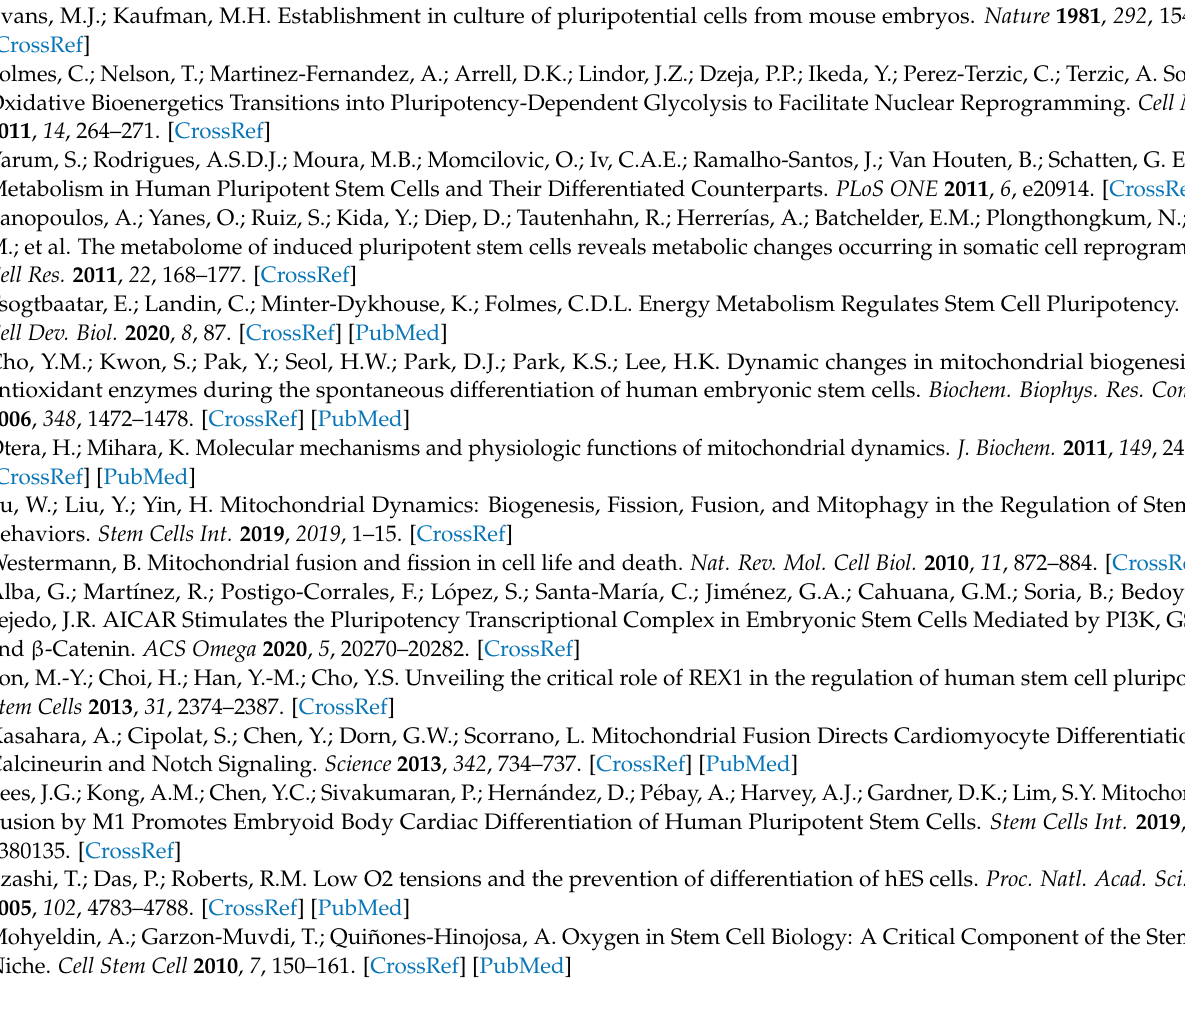
ESCs. Figure S4: 2 µ M DETA-NO reduces red-JC-1 aggregation in human iPSCs. Table S1: List of